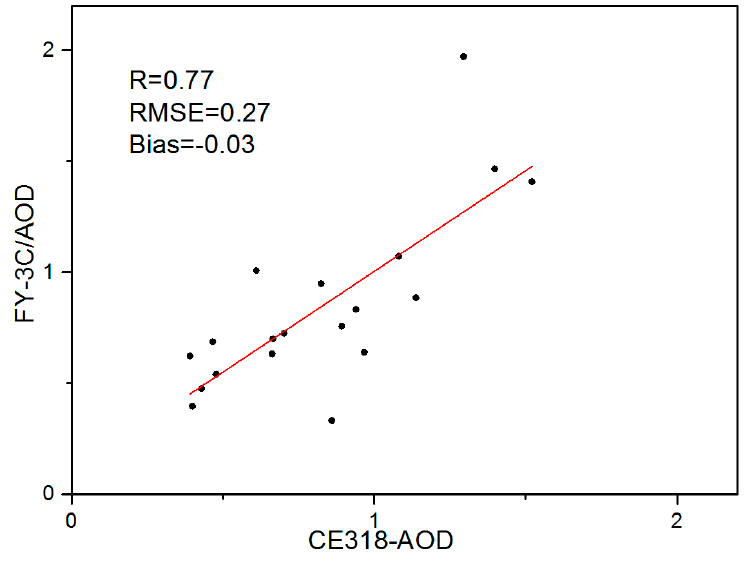
Figure 2. The verification of FY3C/AOD and CE318, the data obtained from May 2014 to May